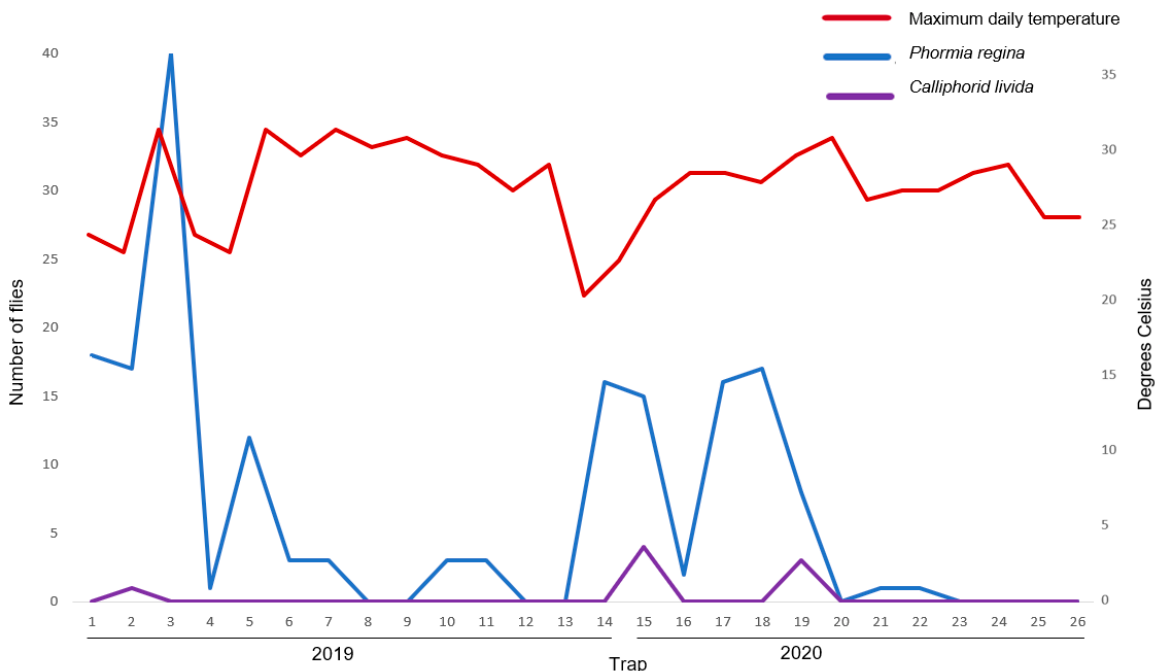
Figure 2. Maximum daily temperature and Phormia regina and Calliphora livida numbers for 2019–2020 traps.